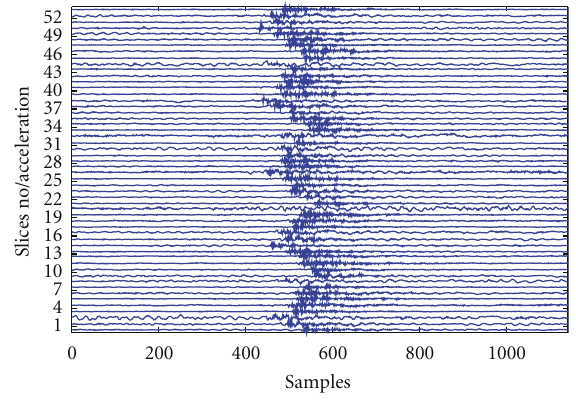
Figure 4: Slices of bearing